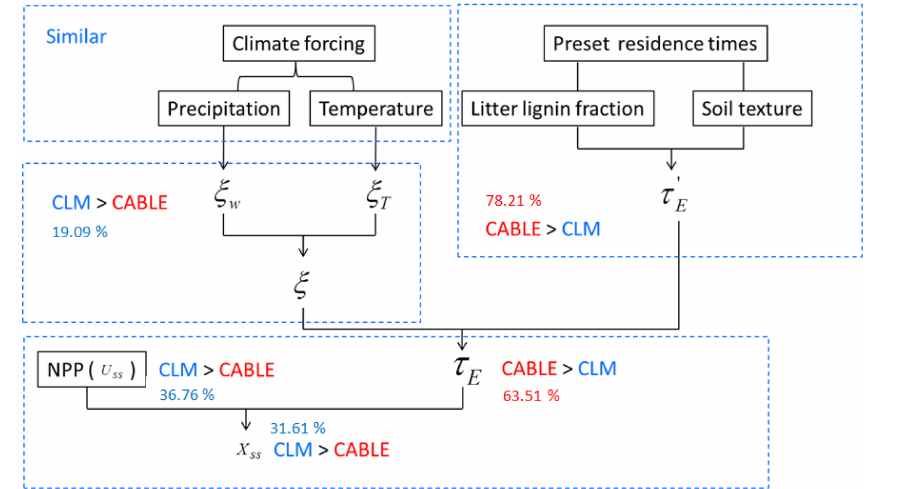
Figure 6. Schematic diagram of the traceability framework along with the summary of the results obtained in this study. The numerical values show the percentage increase between two models. X ss – ecosystem carbon storage capacity; τ E – ecosystem carbon residence time; τ (cid:48) E – baseline carbon residence time; ξ – environmental scalar; ξ T – temperature scalar; ξ W – water